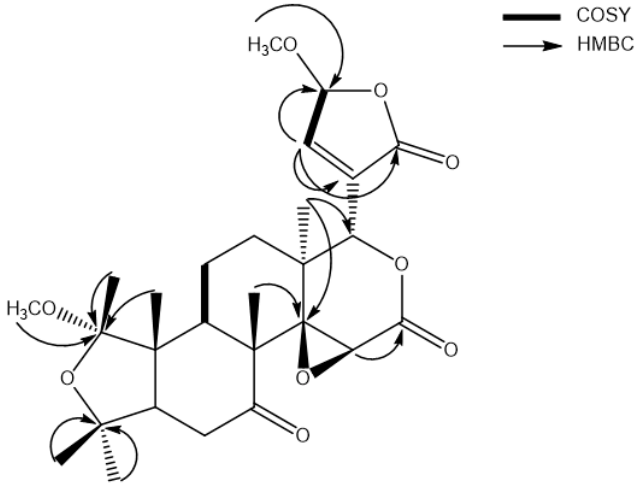
Figure 2. Key 2D NMR correlations for compound 1 .